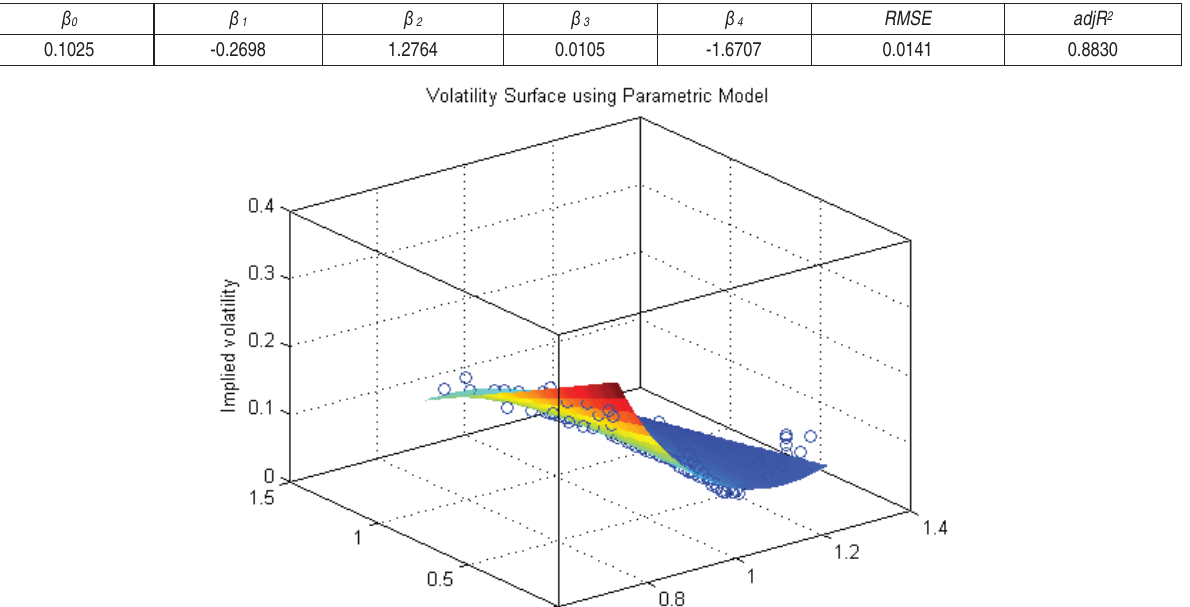
Table 3. Estimated parameters for Model 2, RMSE and R 2 statistic